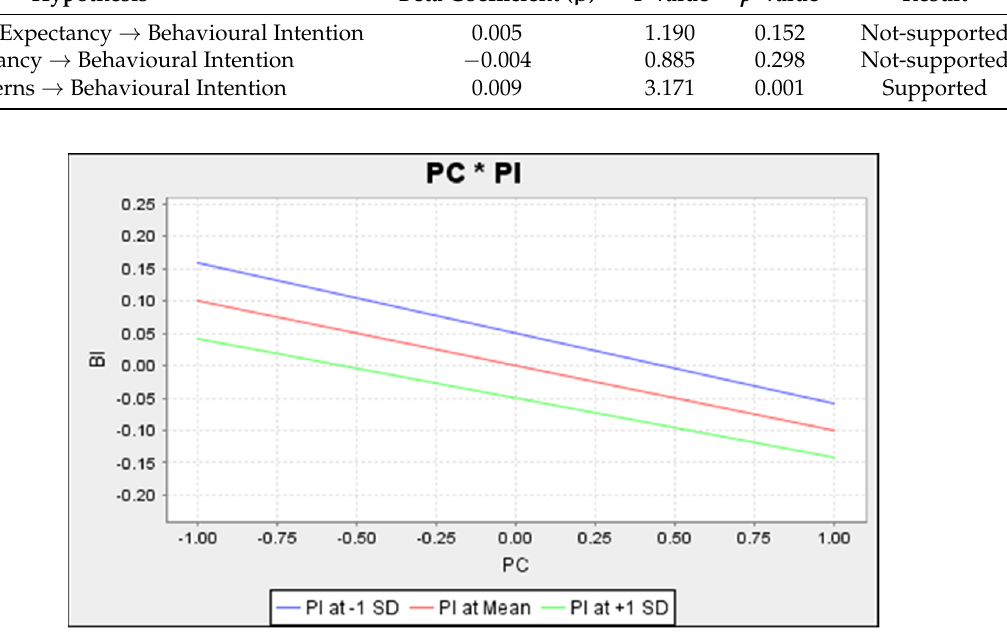
Figure 9. Simple Slope Analysis of Personal Innovativeness on Behavioral Intention.